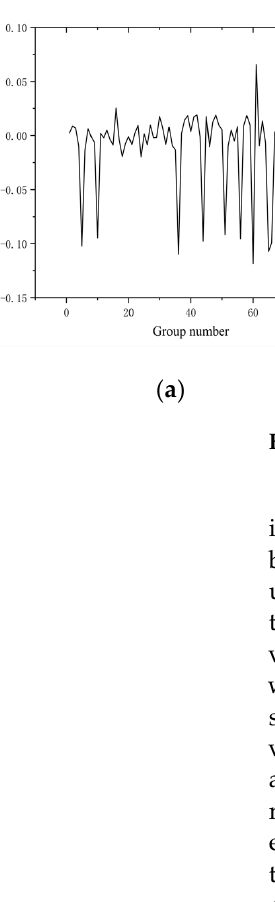
Figure 19. Time − standard value vs. predicted value. ( a ) 20 mm/s. ( b ) 40 mm/s. ( c ) 60 mm/s.